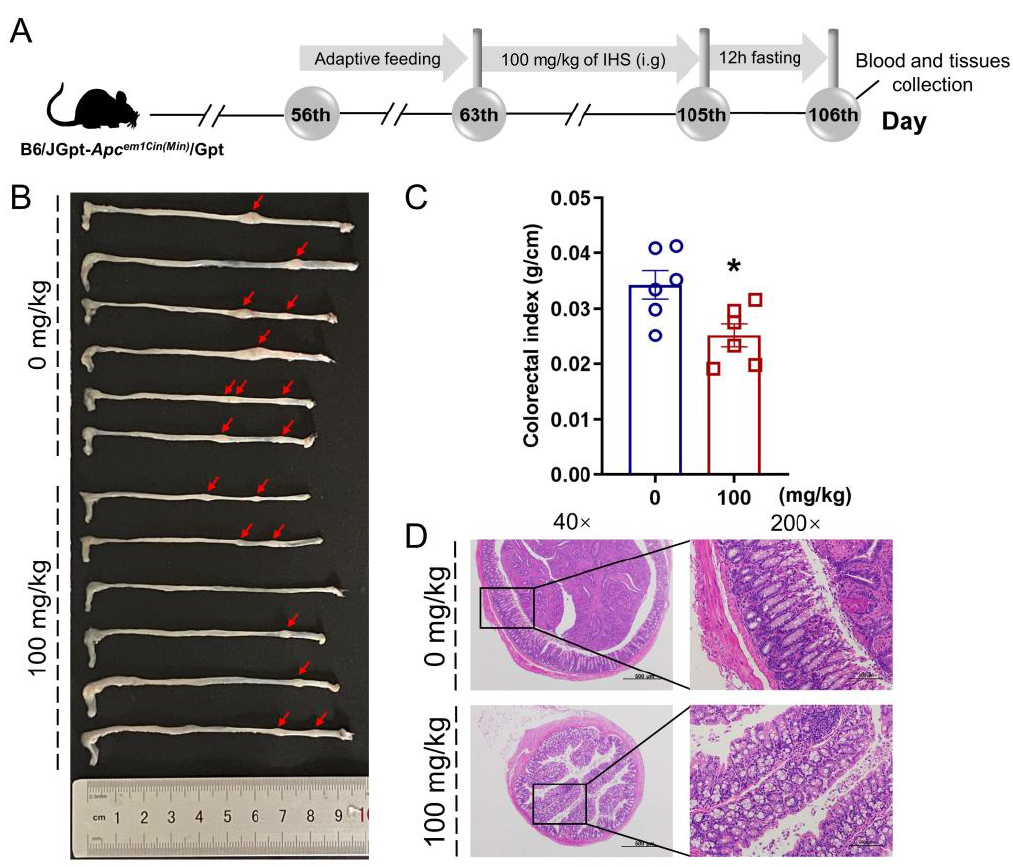
Figure 1. IHS inhibits the growth of CRC in Apc Min/+ mice. ( A ) Animal experiments and agent treatment process; ( B ) Representative photographs of the colorectum of vehicle- and IHS-treated Apc Min/+ mice ( n = 6, each); ( C ) IHS reduced colorectal indexes ( n = 6). Data were analyzed using a one-way ANOVA and are shown as means ± standard error of the man (SEM); * p < 0.05 vs. vehicle-treated Apc Min/+ mice; ( D ) Pathological examination of colorectal tissue through hematoxylin and eosin staining (40×, 500 μm; 200×, 100 μm).